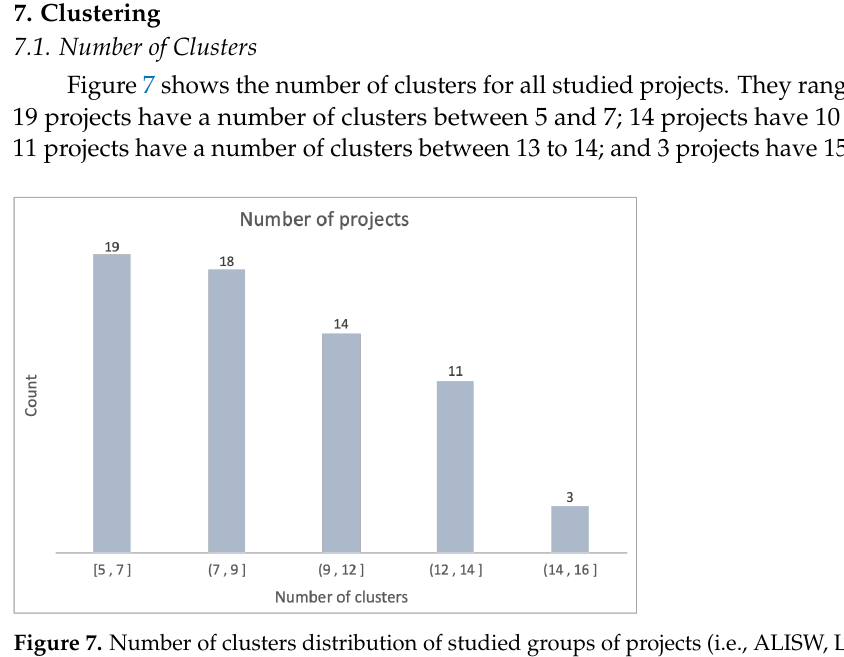
Figure 6. TF-IDF outcome.